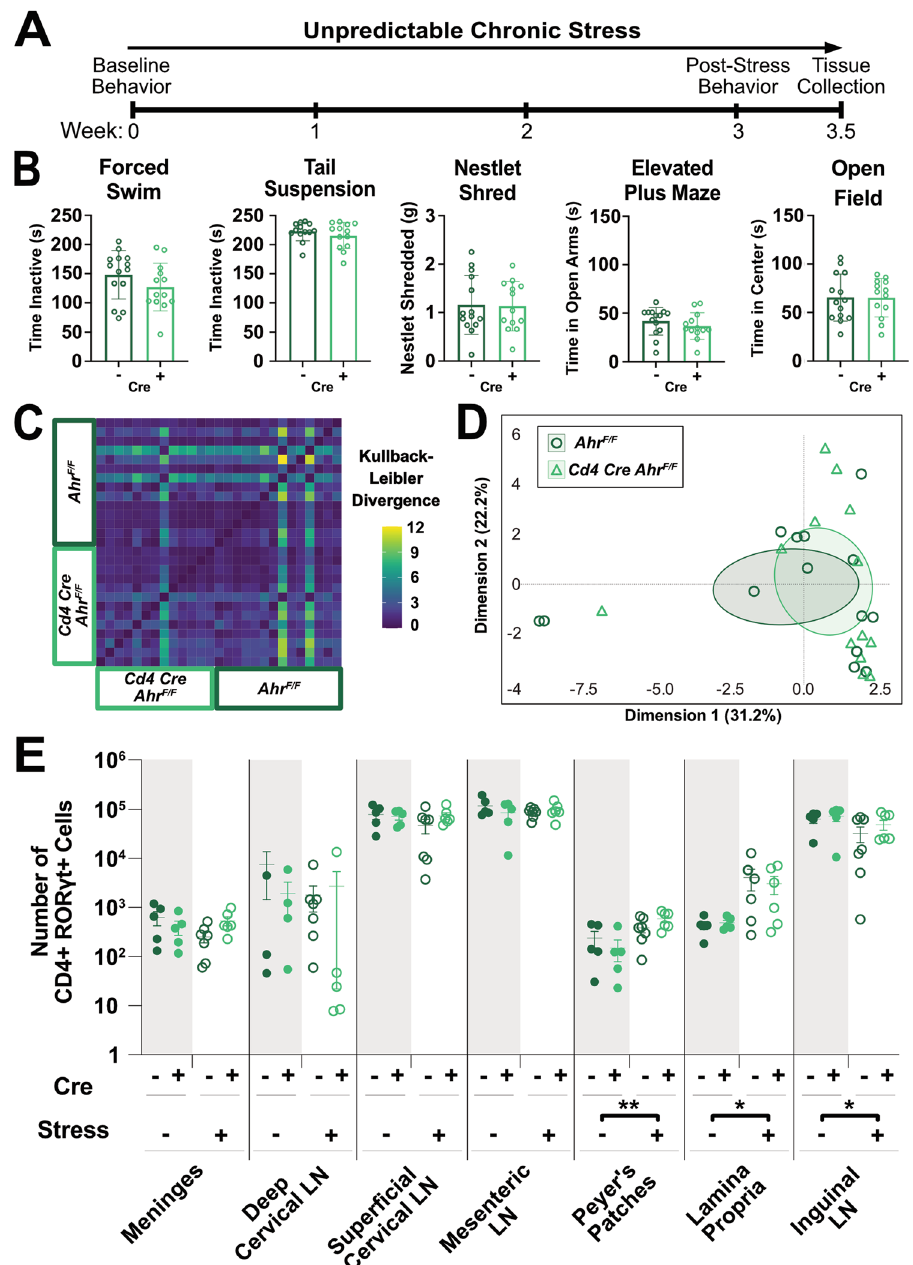
Figure 2. Unpredictable Chronic Stress (UCS) Drives Expansion of Th17s in the Lamina Propria in an Ahr Independent Manner. ( A ) Schematic representing timeline for UCS in mice. ( B ) Measures of learned helplessness and anxiety-like behaviors between Ahr KO and littermate controls (n = 13–14/group). T tests, male mice. ( C ) Kullback–Leibler divergence heatmap and ( D ) PCA plot of DeepLabCut analyzed behaviors between groups (n = 13–14/group). A single representative experiment is shown (N = 2). ( E ) Number of CD4 + ROR γ t + cells in various immune tissues between stressed and naïve Ahr KO and littermate controls (n = 5–7/group). Two-way ANOVA (Peyer’s Patches: p = 0.0026, Lamina Propria: p = 0.0359, Inguinal LN: p = 0.0440), N = 1, male mice. LN =